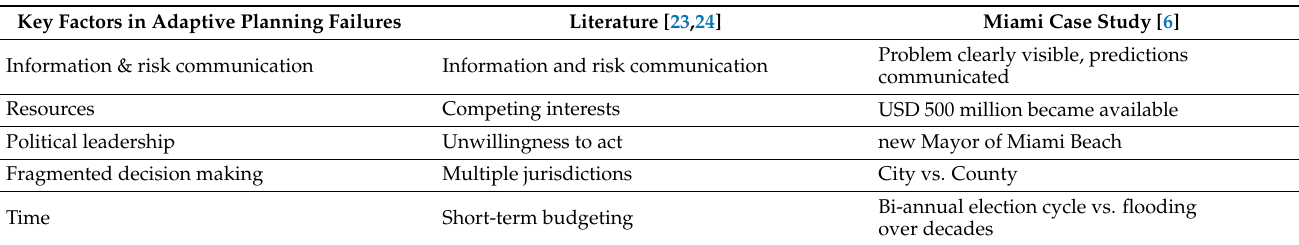
Table 2. Climate change adaptation efforts and limits to